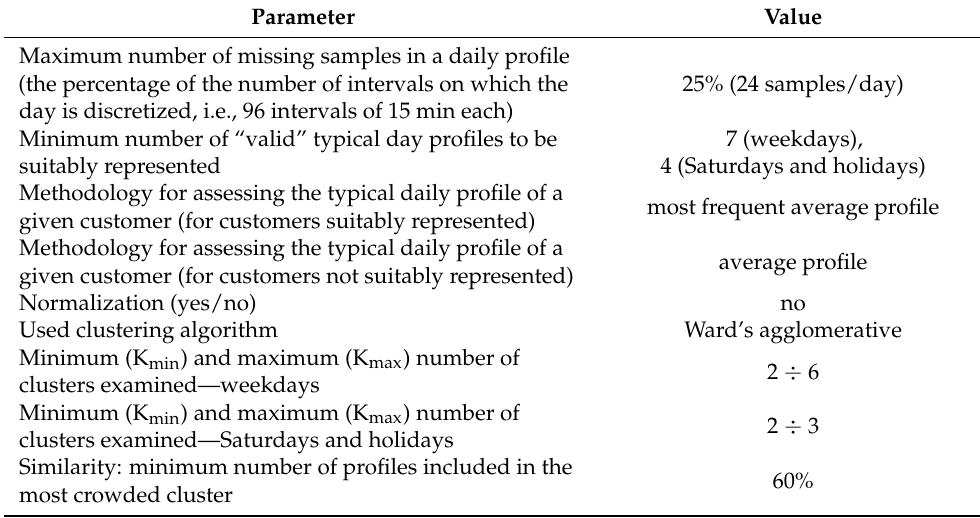
Table 1. Parameters useful for the characterization of the single customer (first stage). Parameter